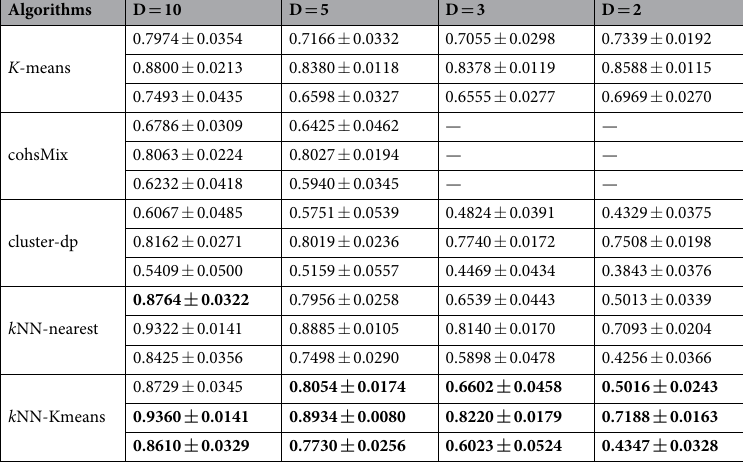
Table 5. Results on LFR networks with numerical attributes, μ = 0.8.